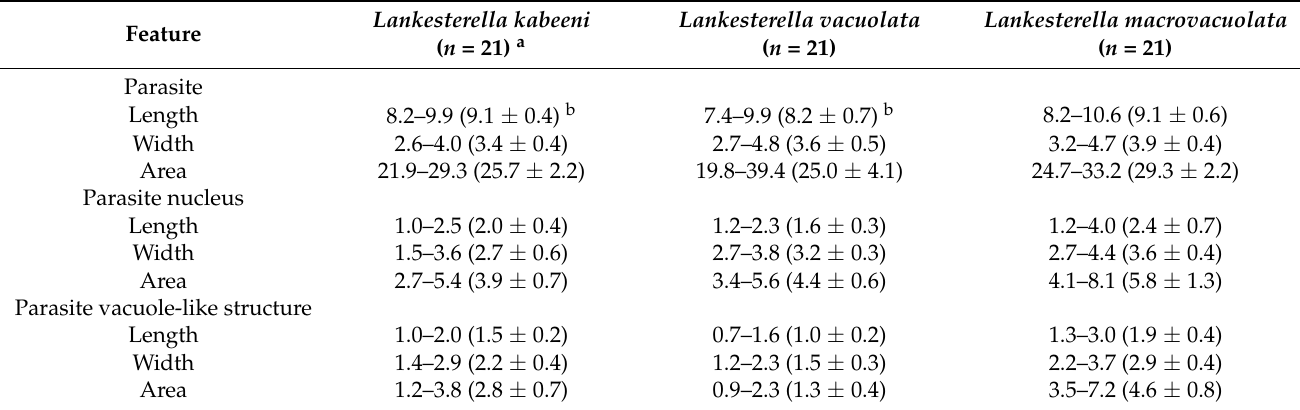
Table 4. Morphometry of sporozoites of Lankesterella kabeeni ( 18S rRNA lineage LanAcro1), Lankesterella vacuolata n. sp. (LanDeli1), and Lankesterella macrovacuolata n. sp.